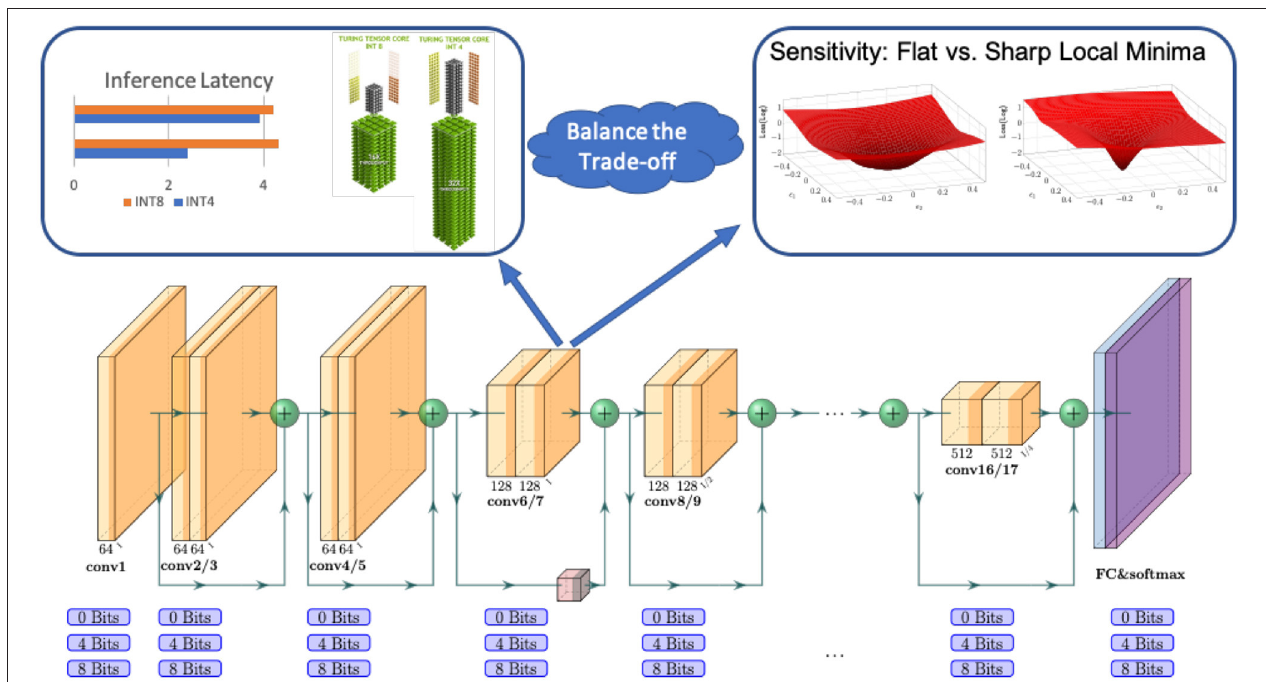
FIGURE 6 | The illustration of hardware-aware quantization and pruning. A given NN model can be compressed by using low precision quantization instead of single precision. The extreme case is to use 0-bit quantization which is equivalent to removing/pruning the corresponding neurons. The goal of compression is to find the best bit-precision setting for quantization/pruning to reduce model footprint/latency on a target hardware with minimal generalization